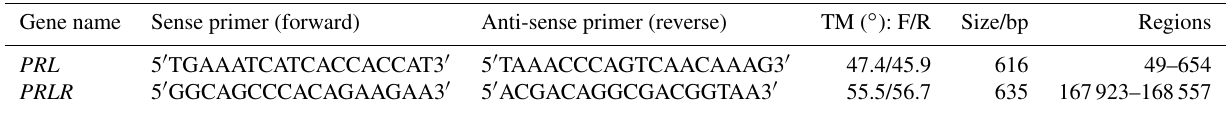
Table A1. Primers used for amplification, sequencing, and genotypic of PRL and PRLR gene coding region.